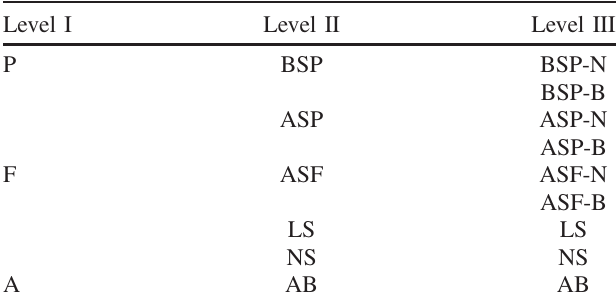
TABLE II. Correspondence between level I, II, and III states.